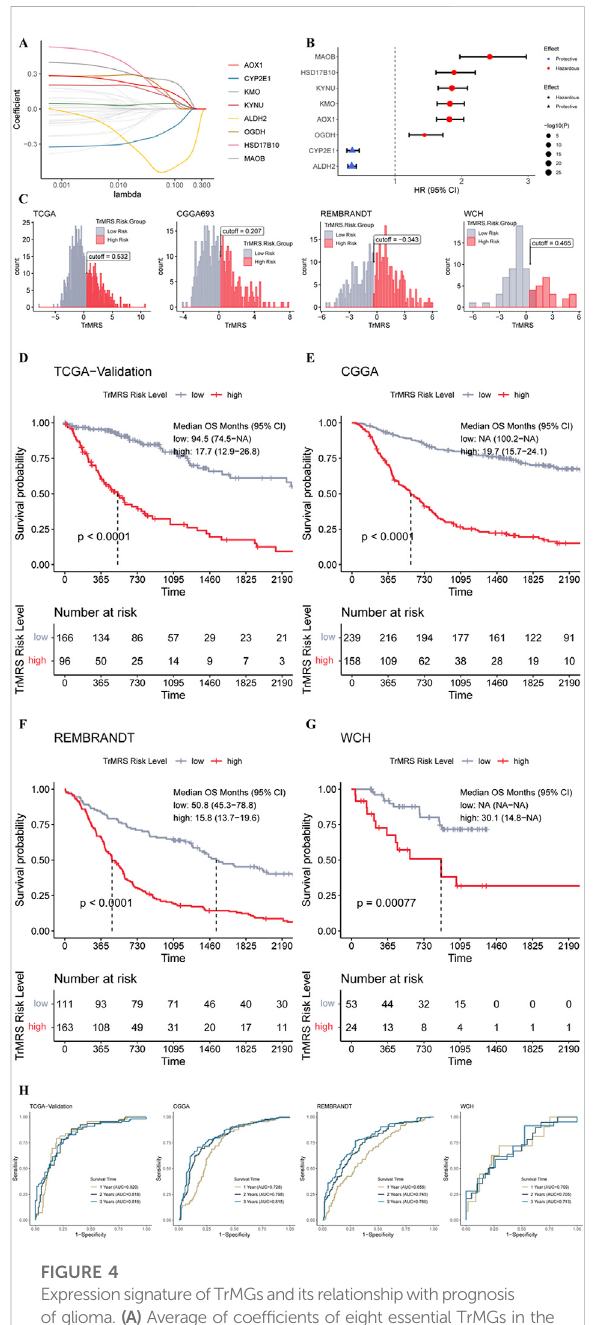
FIGURE 4 ExpressionsignatureofTrMGsanditsrelationshipwithprognosis of glioma. (A) Average of coef fi cients of eight essential TrMGs in the LASSO Cox regression at each lambda value. (B) The effect of each essential TrMG on the prognosis of glioma. (C) Histogram and optimal cut-off values of TrMRS in four cohorts (TCGA: N = 655 with survival data out of 662 in total, CGGA: N = 415, REMBRANDT: N = 369,WCH: N =77). (D) K-McurveoftheTCGAvalidationset,cutoff= 0.532, (E) CGGA cohort, cut off = 0.207, (F) REMBRANDT cohort, cut off= − 0.343,and (G) WCHcohort,cutoff=0.465. (H) ROCcurvesand matched AUC of 1-, 2-, and 3-years survival in all four